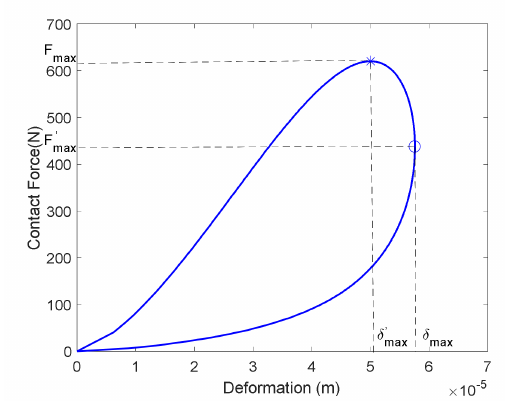
Figure 3. Curve of contact force with respect to deformation.